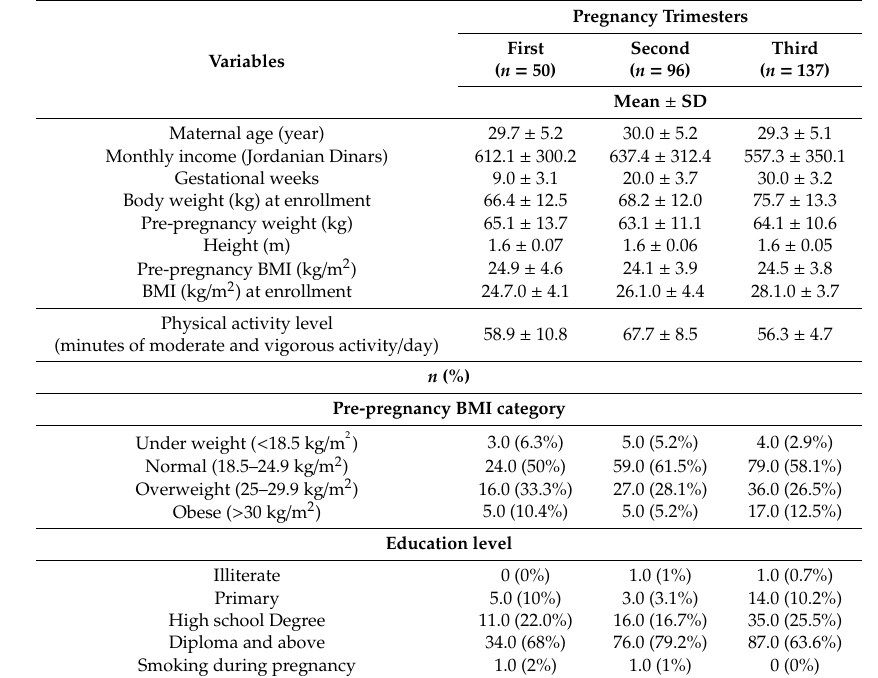
Table 1. Sociodemographic characteristics of participants ( n = 283) enrolled in a cross-section study to assess nutrient intakes of Jordanian pregnant